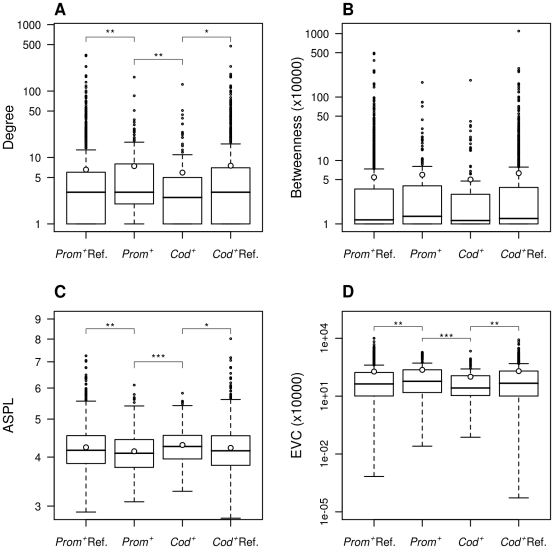
Distributions of the centrality parameters of the IntAct network proteins.
A. Distribution of the degree. The degree of a node, also known as connectivity, is the number of its interacting partners. It is a local measure of centrality, which means that it is not affected by the topology of other regions in the network. B. Distribution of the betweenness. Betweenness centrality is a parameter that is roughly defined as the number of shortest paths between pairs of nodes in the network that pass through a given node and is interpreted as a measure of the importance of a node for the flow of information through the network. As the betweenness distribution contains zeros, we have added 1 unit to the betweenness values to be able to plot the distribution in log scale. C. Distribution of the ASPL. The ASPL value of a node is the average shortest path length between the node and all other nodes in the network and can be interpreted as a measure of geometrical centrality. Notice that the more central a node, the smaller its ASPL. D. Distribution of the Eigenvalue centrality (EVC). The EVC of a node is its associated score in the eigenvector of the largest eigenvalue of the adjacency matrix; in a protein network with unweighted edges, nodes with high EVC are those that are connected to many nodes, which are, in turn, connected to many other nodes and so on. Prom+: genes with positively selected proximal promoters (n = 188); Cod+: genes with positively selected coding regions (n = 152); Prom+ Ref.: the reference set for Prom+ (n = 2219); Cod+ Ref.: the reference set for Cod+ (n = 1811). The open circle shows the mean of the distributions. *P<0.05, **P<0.01 and ***P<0.001.